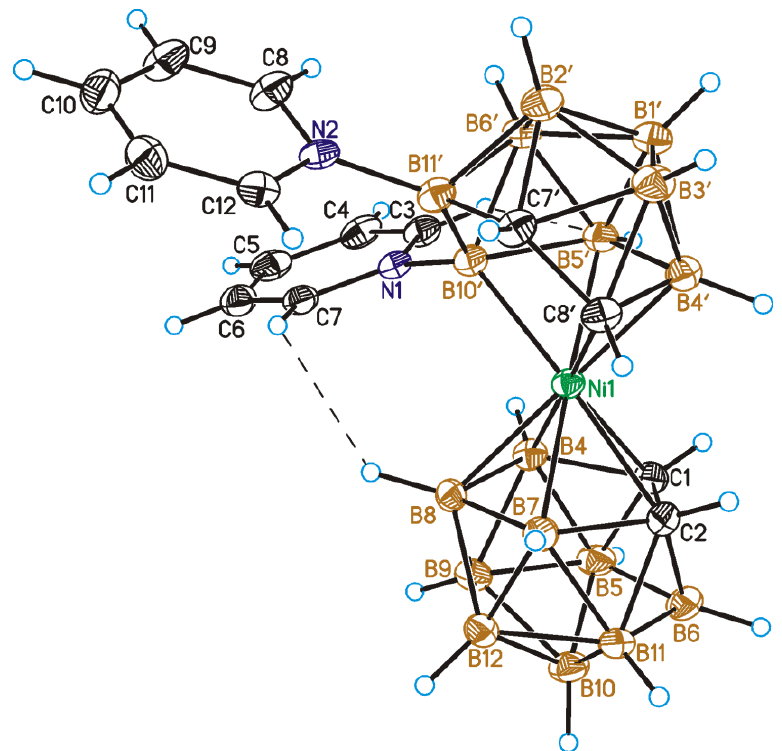
Figure 1. General view of complex 2 showing atomic numbering intramolecular CH ‧‧‧ HB contacts. Thermal ellipsoids are drawn at 50% probability level.